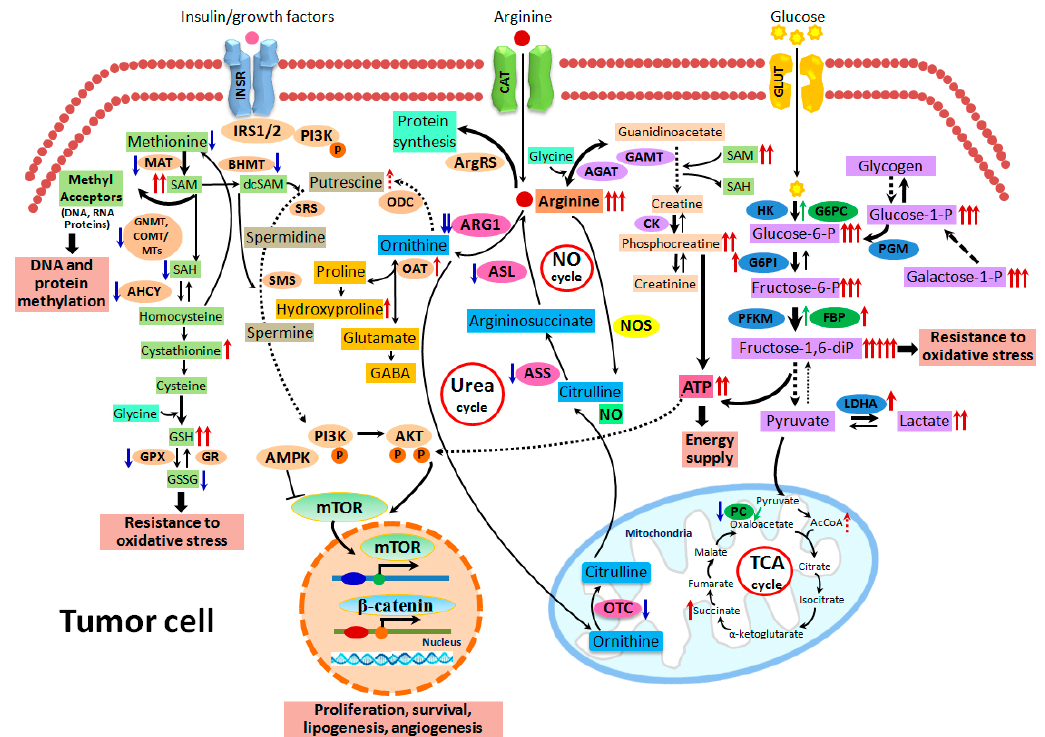
Figure 7. Metabolome and proteome alterations in the liver tumor cells of TSOD mice. Marked changes of glycolytic, gluconeogenic, fructose, galactose, pyruvate, methionine, glutathione and creatine metabolism in HCCs of TSOD mice were closely associated with L-arginine accumulation, and activation of mTOR and β -catenin signaling pathways.